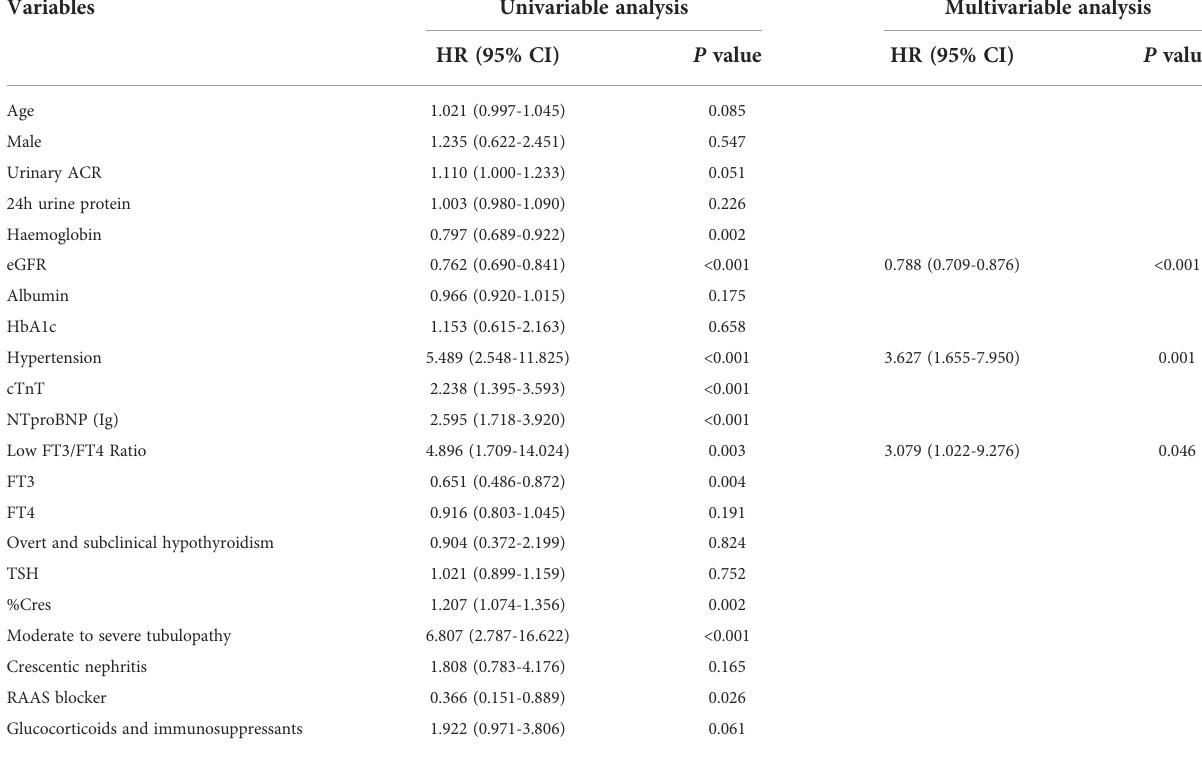
TABLE 2 Associations between clinical, laboratory and pathological parameters and primary combined